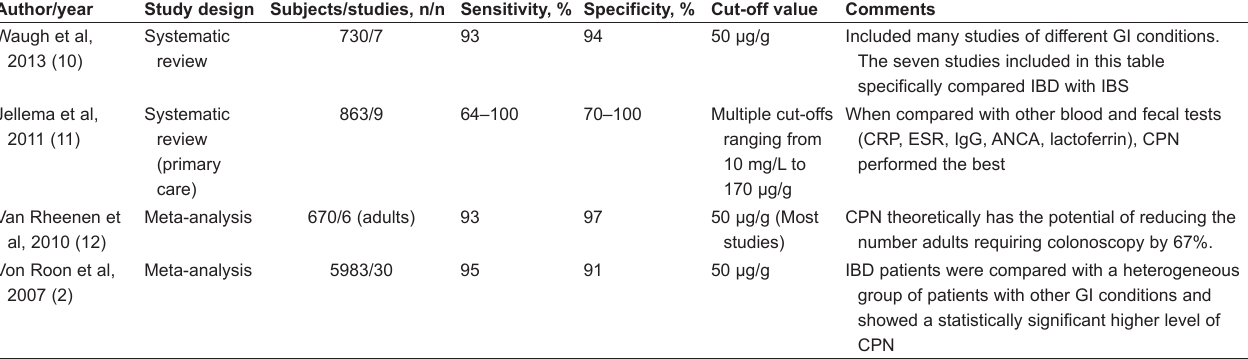
TABLE 2 Studies evaluating the performance of fecal calprotectin (CPN) in distinguishing inflammatory bowel disease (IBd) from